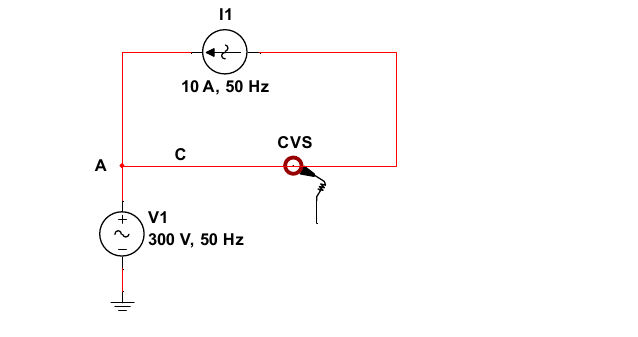
Figure 11. Virtual load connection, by means of a current transformer (CT) and a voltage autotransformer (VAT) for the characterization of the CVS. As for the voltage, an elevator autotransformer (VAT in Figure 11) with variable ratio was used — for the scope of this paper a ratio of about 3.33 was chosen. As for the current, a wound type current transformer (CT in Figure 11) for low voltage systems, with ratio of 15 A/5 A and rated burden of 20 VA, was used: The output of the current generator I2 was connected to the secondary winding, while the primary winding was short-circuited with the conductor C. The CVS was inserted around the conductor C and this was connected to the output of the VAT (i.e., the node A). In this way, the connection shown in Figure 11 is able to provide the same functionality of the scheme in Figure 10.